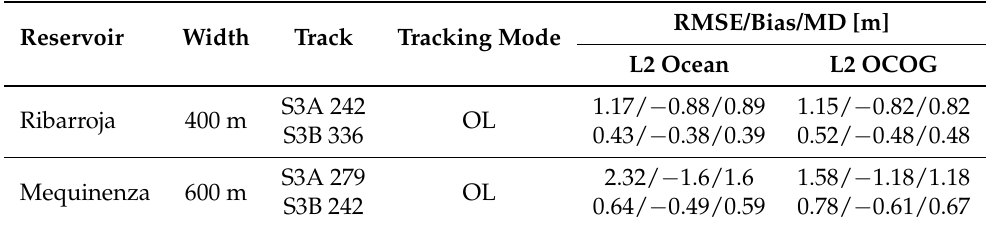
Figure 50. Time series of S3A and S3B L2 derived water level over ( a ) Ribarroja Reservoir, ( b ) Mequinenza Reservoir. Table 7. Results of the S3A and S3B water level comparison with in situ data (December 2018–December